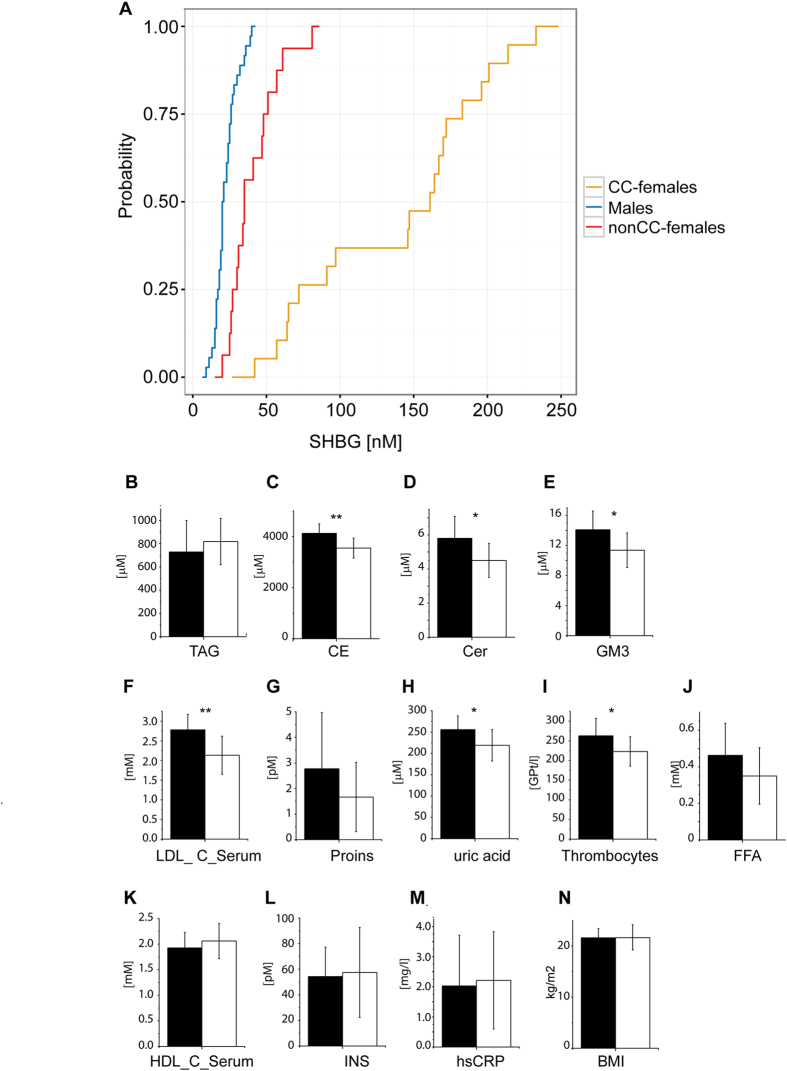
Elevated concentration of SHBG in CC-females favourably impacts both plasma lipidome composition and clinical indices related to lipid metabolism.(A) Cumulative distribution of the SHBG concentration in males (n = 36); nonCC-females (n = 16); CC-females (n = 19). (B–N) Concentrations of some lipid classes (B–E) and clinical indices (F–N) in CC-females with low (SHBG < 130 nM; n = 7; filled bars) and high (SHBG > 130 nM; n = 12; unfilled bars) SHBG levels. *p < 0.05; **p < 0.01; ***p < 0.001 (Mann-Whitney nonparametric test). Data are the mean ± SD.